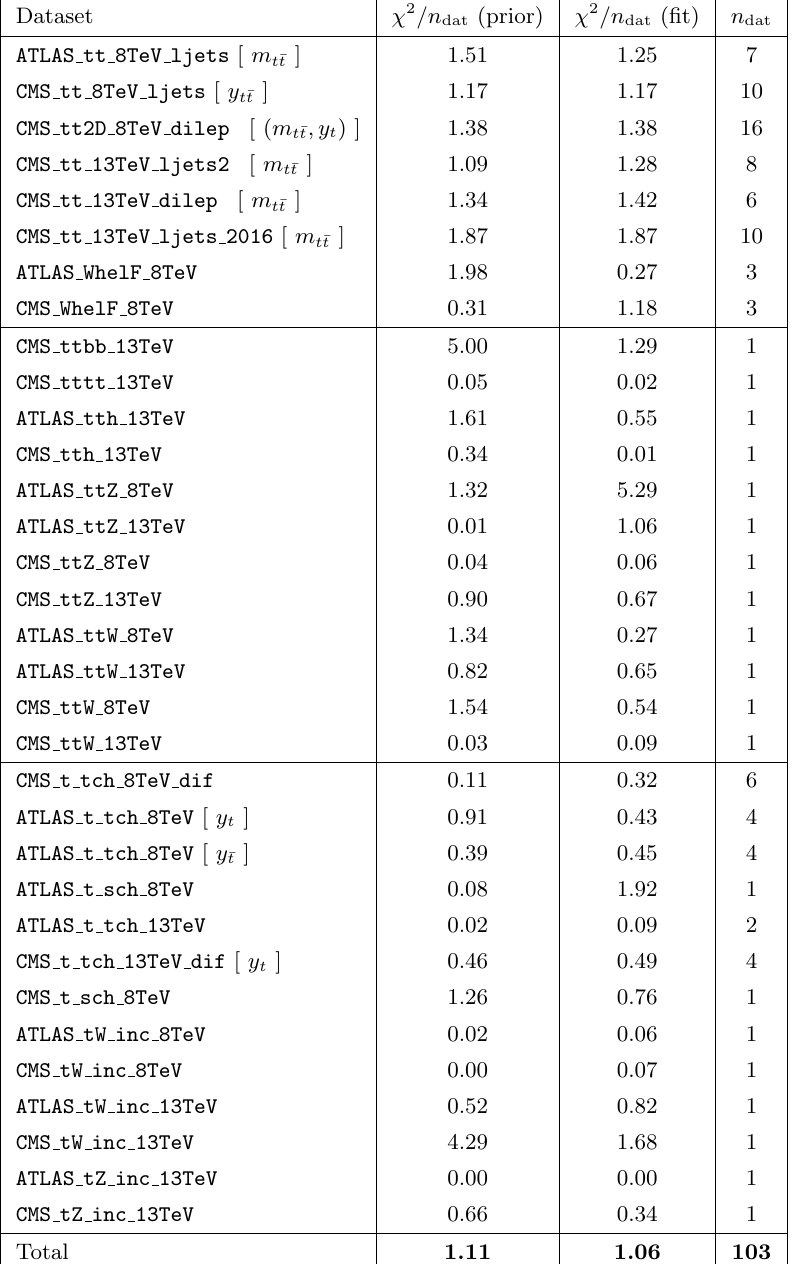
Table 7 . The values of the (cid:31) 2 per data point for each of the datasets included in the (cid:12)t. In each case, we indicate the values of (cid:31) 2 =n dat (cid:12)rst when the theory calculations include only the SM contributions (second column) and then once they account for the SMEFT corrections, after the (cid:12)t (third column). In the last column we indicate the number of data points n dat . Datasets are classi(cid:12)ed in three groups following the structure of tables 2{4: inclusive top quark pair production; t (cid:22) t production in association with heavy quarks, vector bosons, and Higgs bosons; and inclusive and associate production of single top quarks. In the case of datasets made of multiple di(cid:11)erential distributions, we indicate the one that has been used in the analysis.